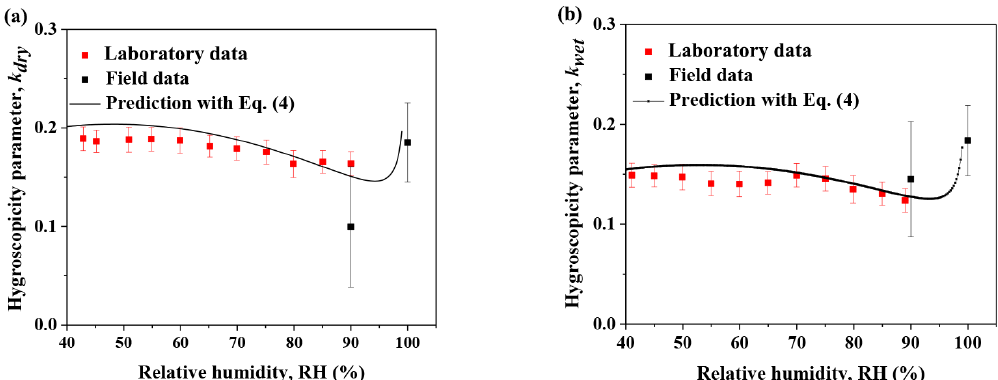
Figure 6. Hygroscopicity parameter, κ , representing mixed aerosol particles consisting of organic surrogate components and ammonium sulfate at different periods (initial dry diameter of 100nm at RH < 5%). The black curves in both panels show the κ prediction from Eq. (4) with HGF mix calculated with Eq. (6) using component volume fractions and the HGF of the individual mixture components from a fit to the laboratory data (using Eq. 5). The black symbols and error bars show field data from the Amazon Basin during the dry and wet periods at conditions of water vapor subsaturation (HTDMA measurement) and supersaturation ( κ CNN ) (Whitehead et al., 2016; Pöhlker et al.,